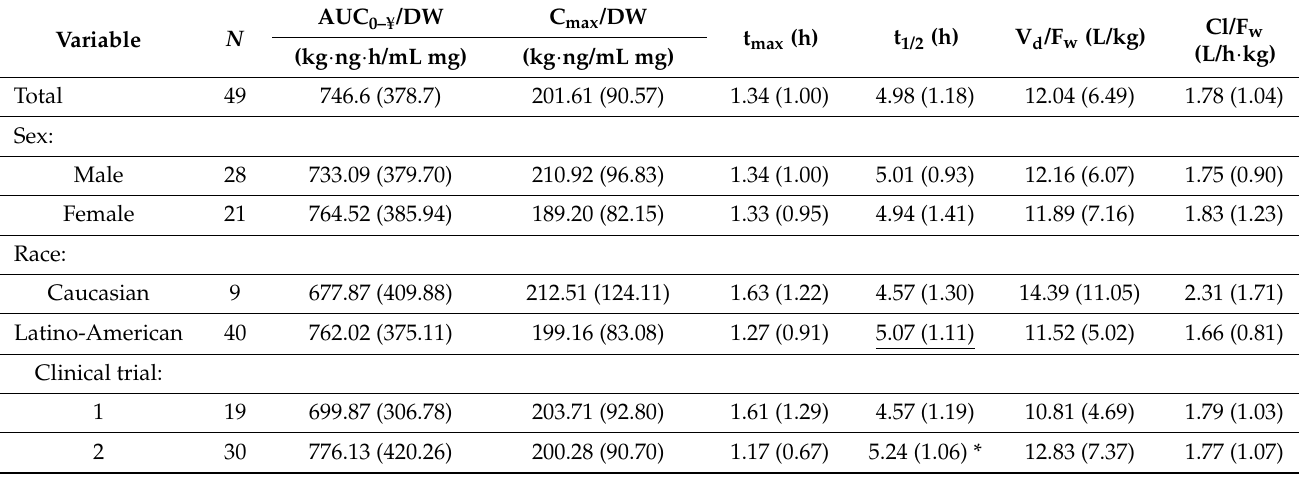
Table 3. Pharmacokinetic parameters according to sex, race, and clinical trial